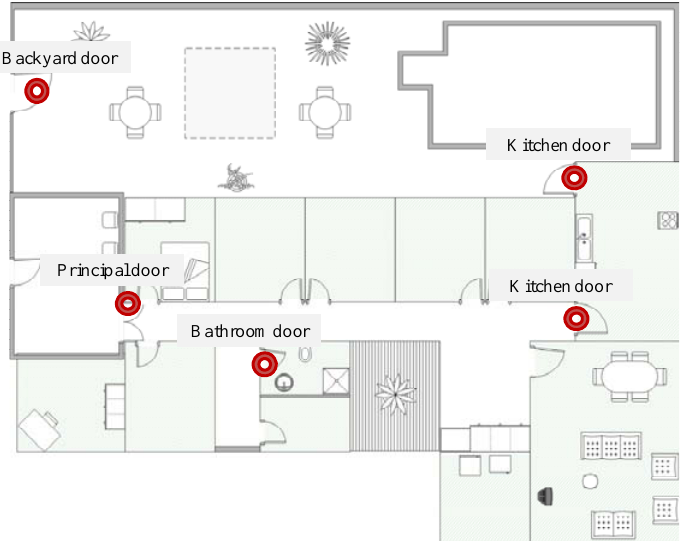
Figure 7. Map of the Nursing Home showing the location of RFID readers.